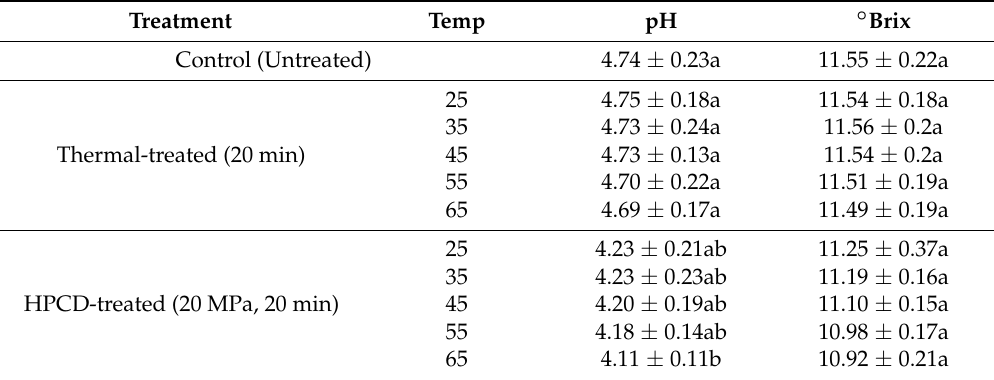
Table 1. pH and brix of quince juice from thermal and HPCD treatments.